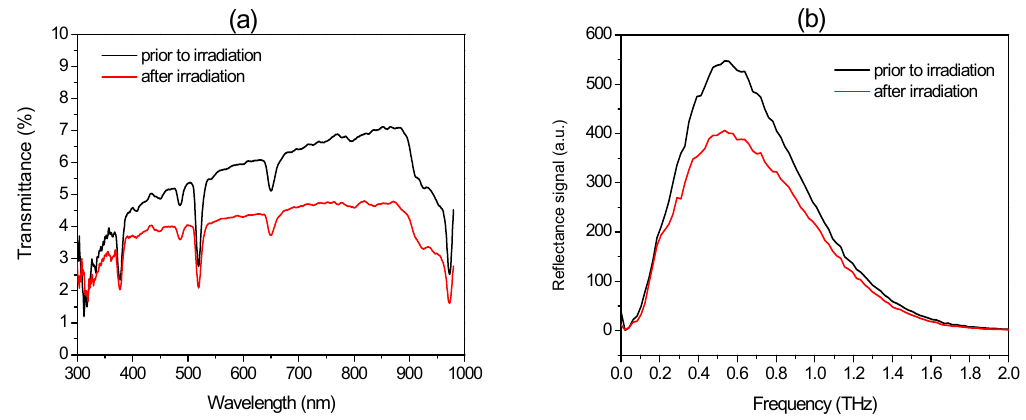
Figure 4. UV-Vis-NIR transmittance ( a ) and reflectance in THz range ( b ) spectra of the glass with x = 2.5 prior to and after irradiation.